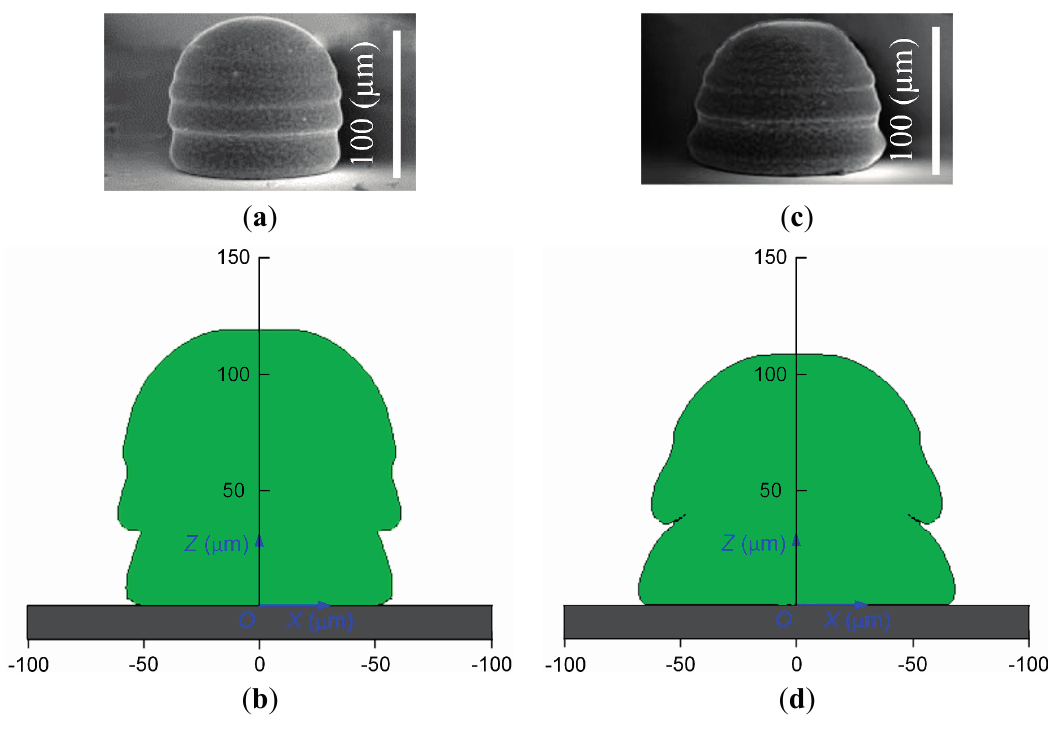
Figure 3. Comparison of SEM photo and simulation results of two 100- μ m diameter aluminum alloy droplets impacting on a H13 stainless steel substrate: ( a ) pileup endshape with a velocity of 1.5 m/s, the droplet spacing is 200 μ m; ( b ) simulated pileup endshape with a velocity of 1.5 m/s, the droplet spacing is 200 μ m; ( c ) pileup endshape with a velocity of 2.5 m/s, the droplet spacing is 260 μ m; ( d ) simulated pileup endshape with a velocity of 2.5 m/s, the droplet spacing is 260 μ